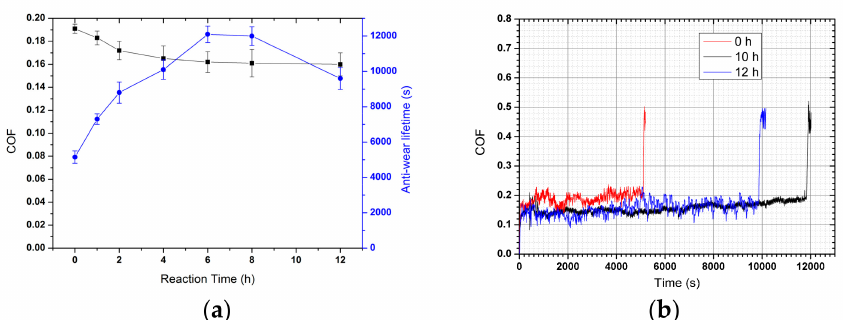
Figure 4. The influence of reaction time for hydrothermal reduction on COF and Anti-wear lifetime of HRGO-APS coating on TNTZ alloy substrates ( a ); COF vs time curves of coatings with three di ff erent reaction times—0 h (GO-APS coating), 10 h and 12 h ( b ).